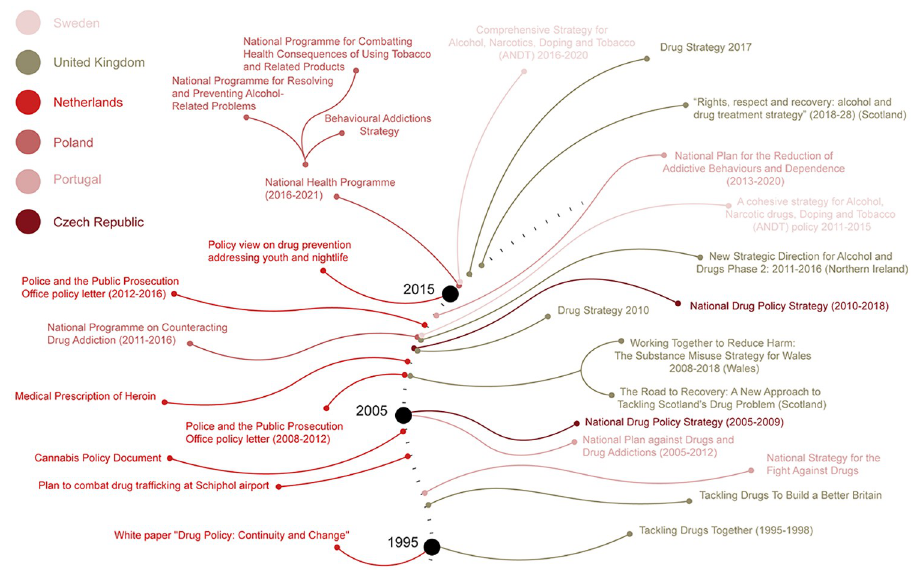
Fig 3. An overview of the national drug strategies adopted by the jurisdictions under study.